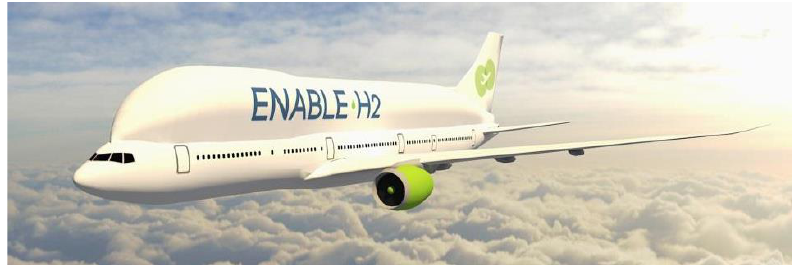
Figure 18. Artistic view of the aircraft designed in the EnableH2 project [32].